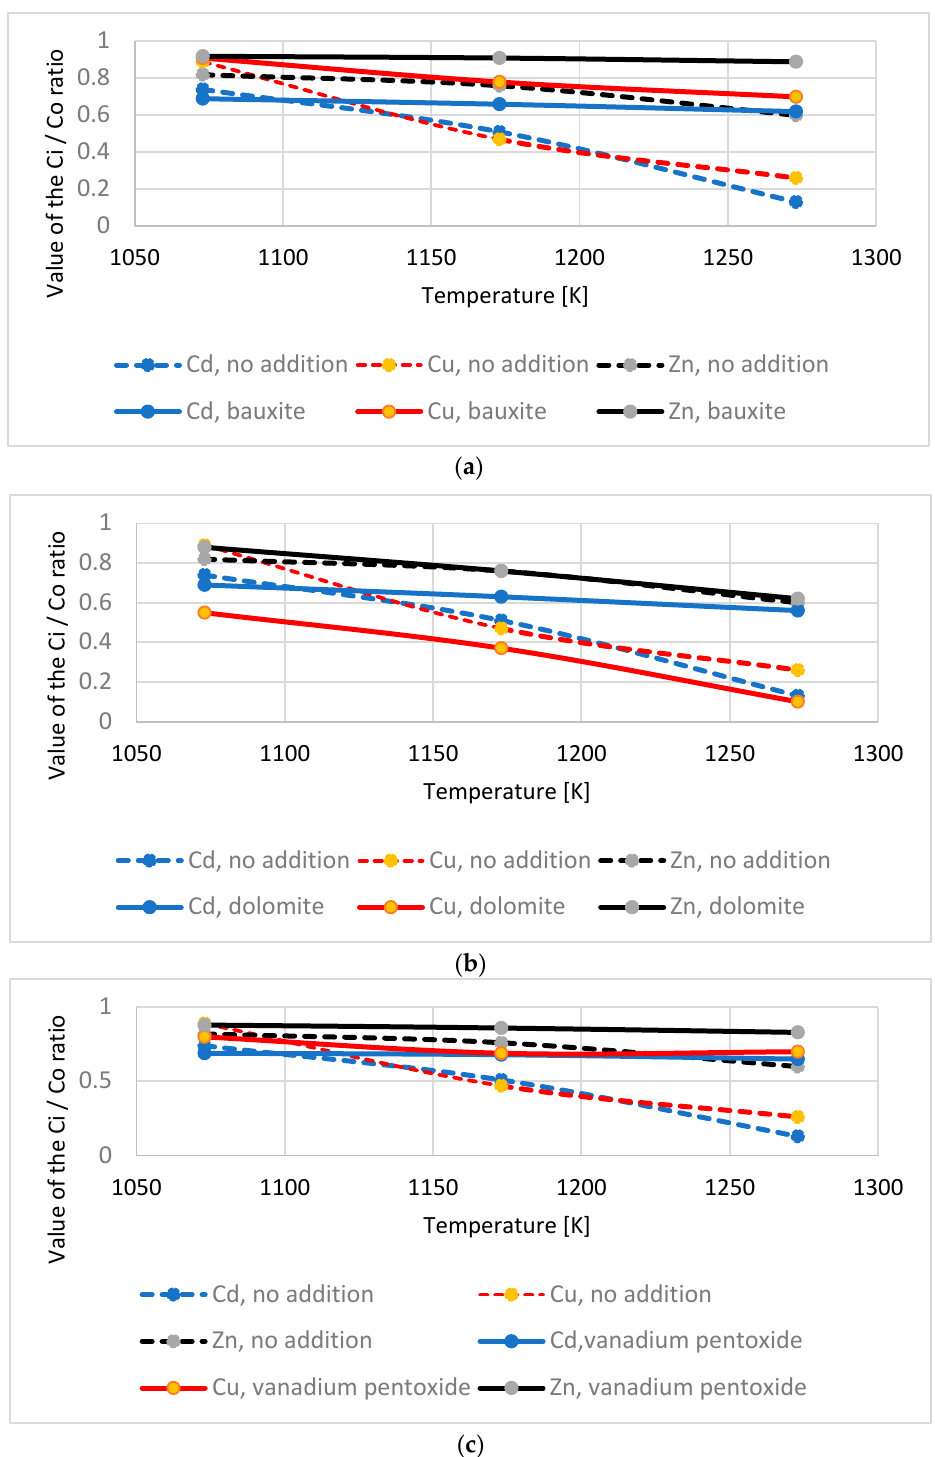
Figure 3. Dependence of Ci/Co value on roasting temperature in chloride samples); ( a ) with the addition of bauxite, ( b ) with the addition of dolomite, ( c ) with the addition of V 2 0 5.